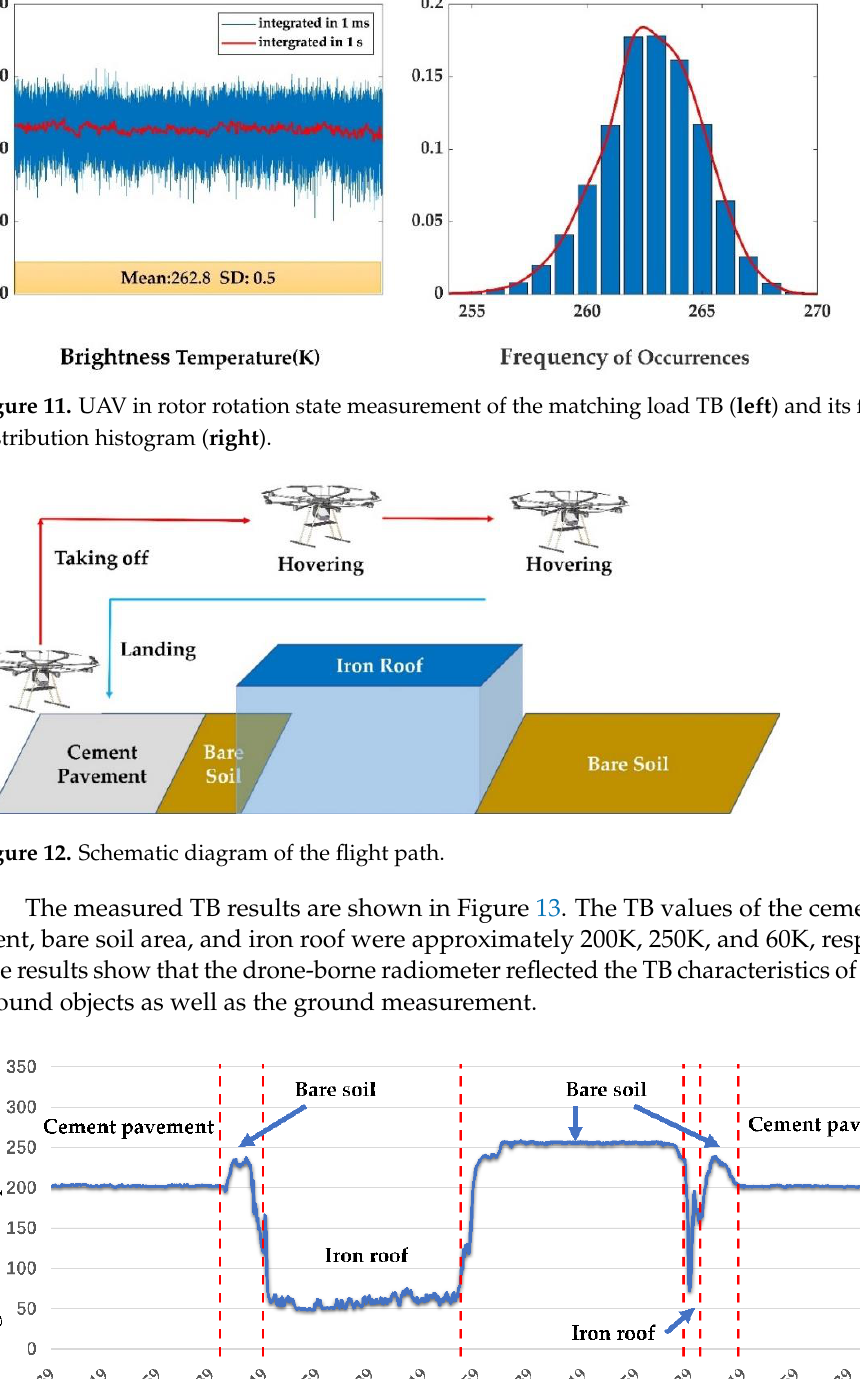
Figure 11. UAV in rotor rotation state measurement of the matching load TB ( left ) and its frequency distribution histogram ( right ).